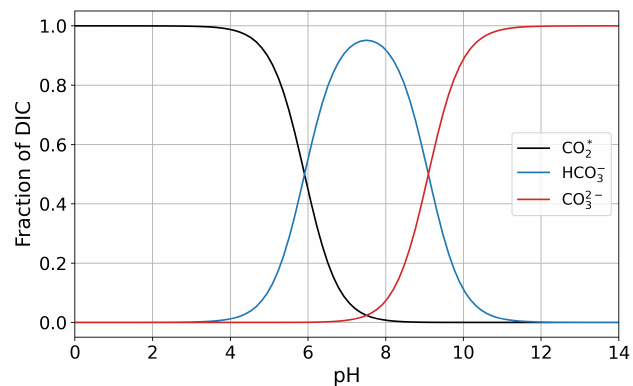
Figure 6. The ocean carbon buffer system. The equilibriums and dominant species were calculated using Equation (4) through (7). Dissolved inorganic carbon (DIC) is the sum of the three species.